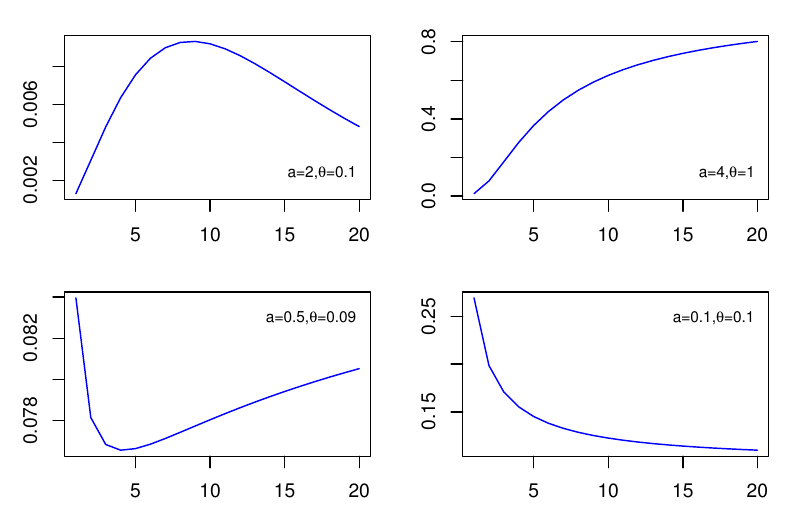
Figure 2 – The hrf is plotted for different values of a and θ